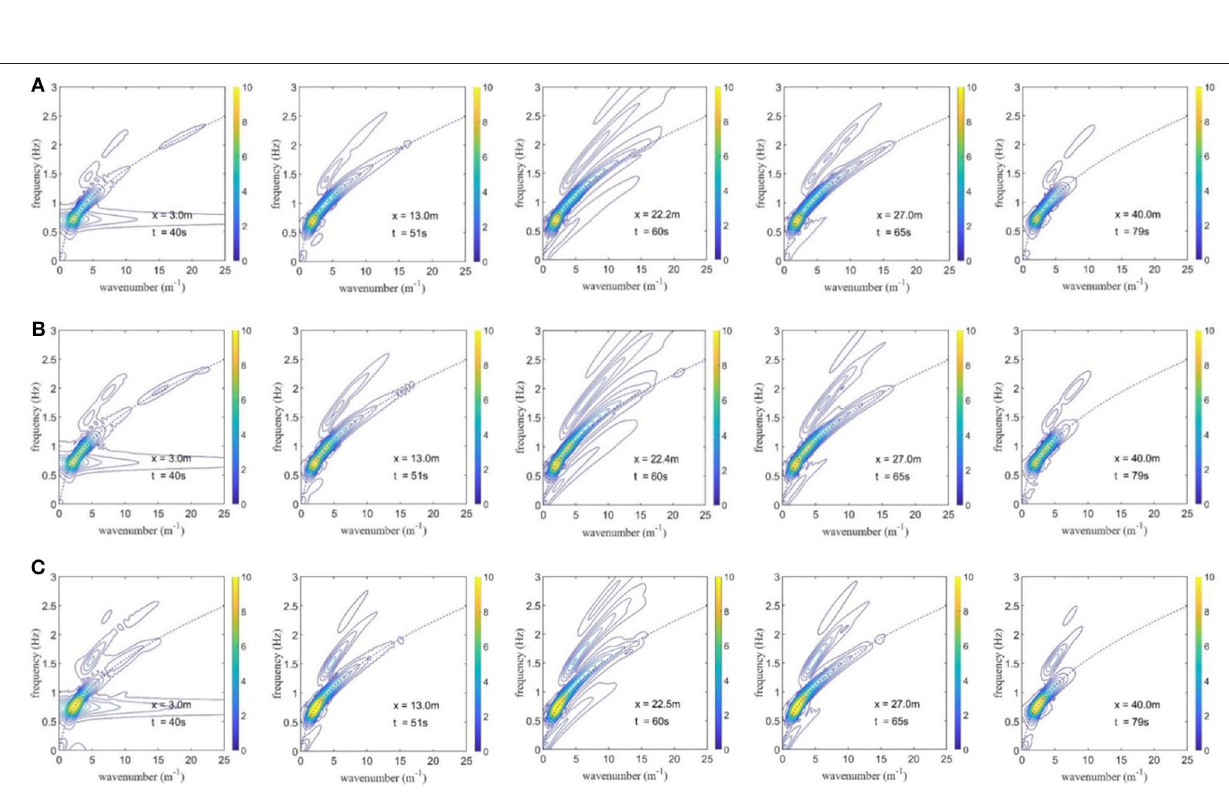
Frontiers in Energy Research |